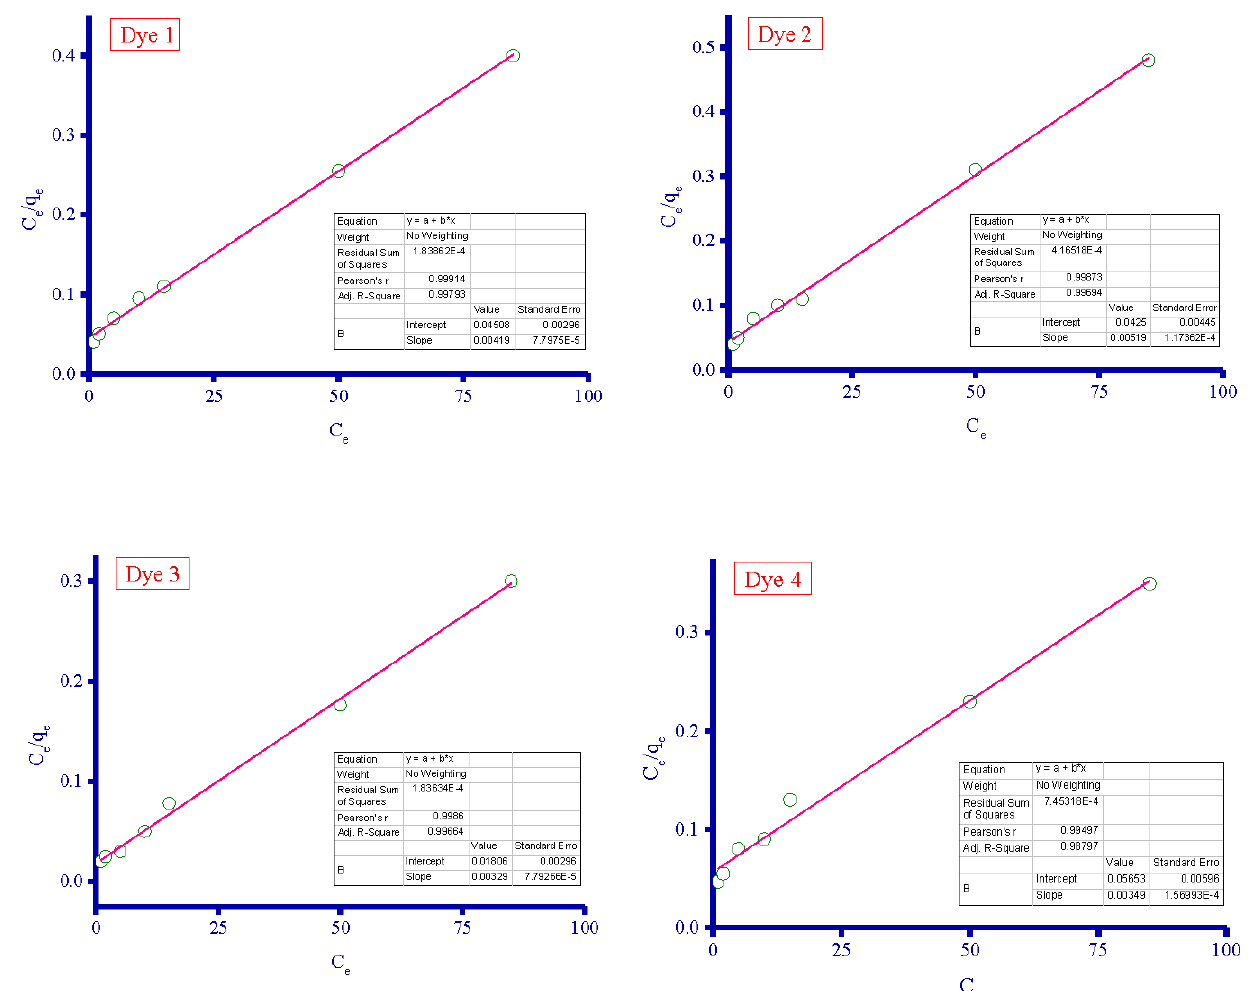
Figure 11. Langmuir isotherm plots for the investigated dyes (Dye 1–Dye 4).